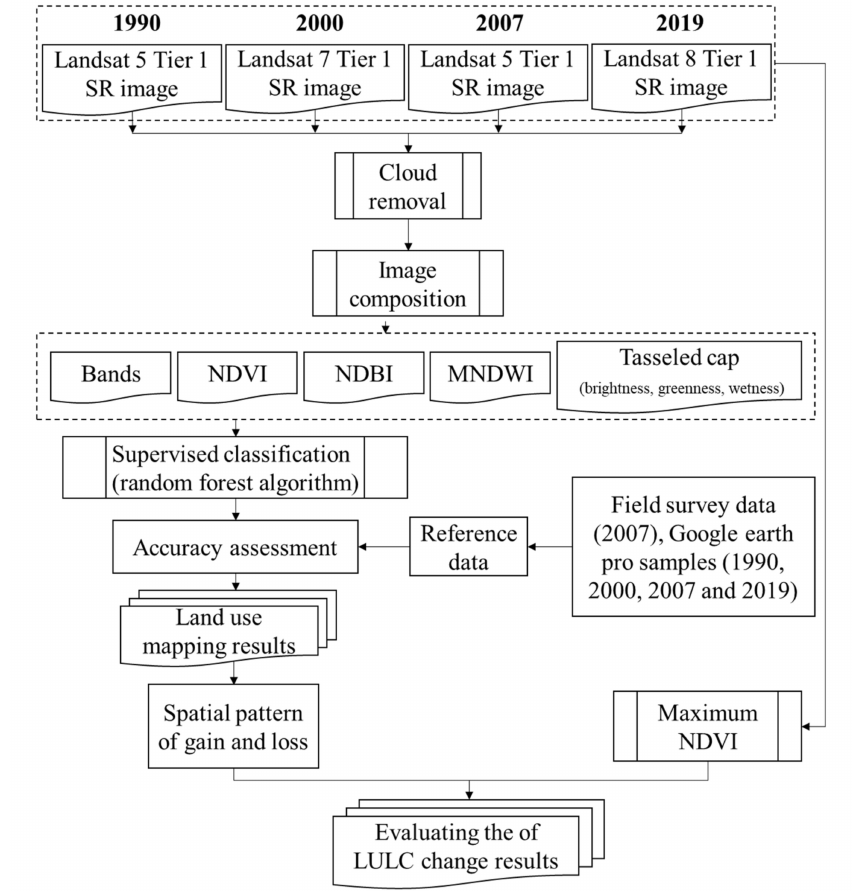
Figure 2. The flowchart of data processing in this study. SR = Surface reflectance; NDVI = Normalized Di ff erence Vegetation Index; NDBI = Normalized Di ff erence Built-up Index; MNDWI = Modified Normalized Di ff erence Water Index; LULC = Land use and land